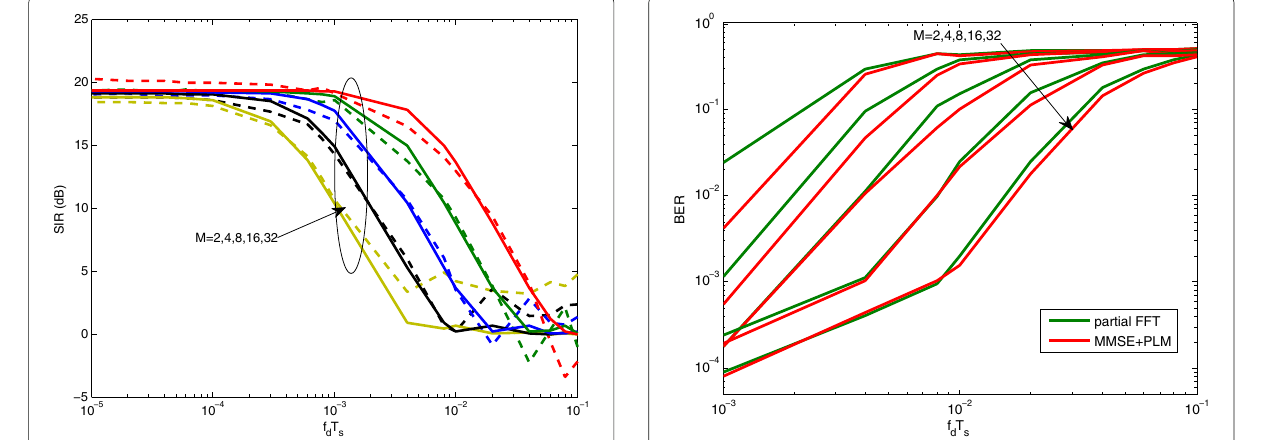
the OFDM symbol duration T is about 1 ms. The binary phase shift keying (BPSK) is employed to investigate the bit error rate (BER) performance. The channel coeffi- cients are generated by Jakes’ model, and the exponential power delay profile ( 0, − 4.3429, − 8.6859 dB ) is employed. Additionally, the channel coefficients between different paths are independent identically distributed (i.i.d) with the same maximum normalized Doppler frequency F d T s .